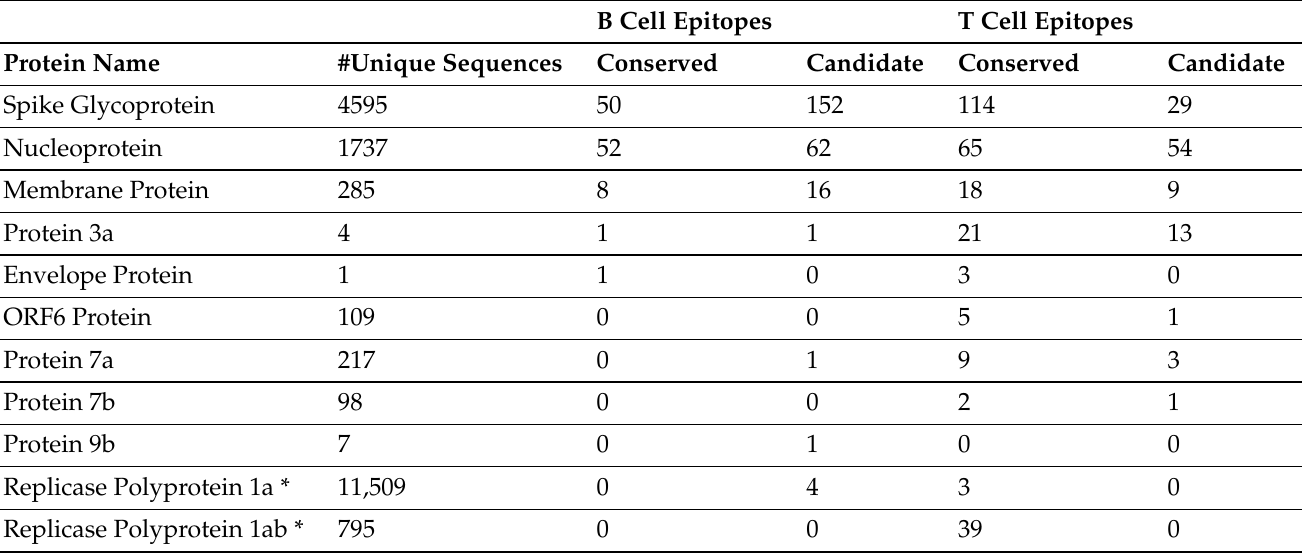
Table 1. Epitope distribution by protein. * indicates that analysis on Replicase Polyprotein 1a and 1ab is limited Section